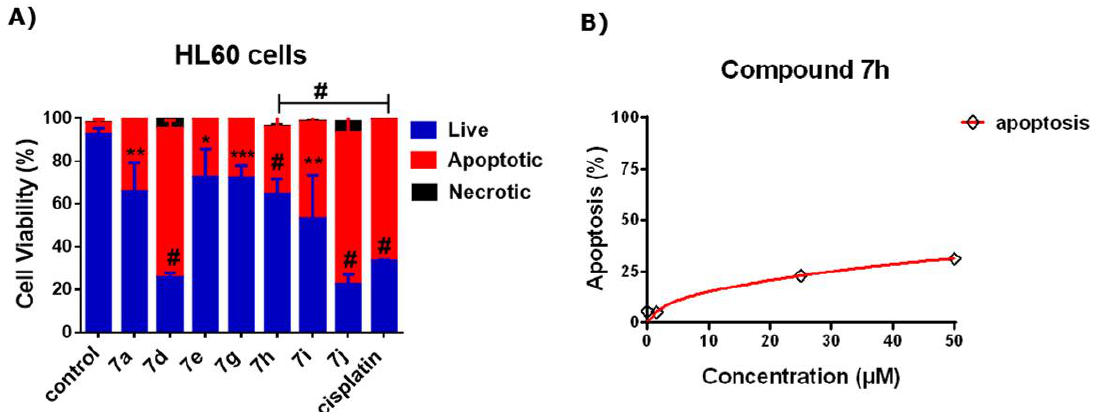
Figure 7. Viability of HL-60 cells. Cells were stimulated for 24 h with the different compounds (50 μM). Cells were then stained with propidium iodide (PI; 10 μg/mL), and cell viability and cell death by apoptosis or necrosis were evaluated by flow cytometry. ( A ) Graphical representation after quantification of the percentage of cells in each quadrant of the dot plot. ( B ) graphical representation of apoptosis percentage for the 7h compound at dose range of 1–50 µ M. We obtained these results using the non-treated cells as control. The data represent the average ± SD of three independent